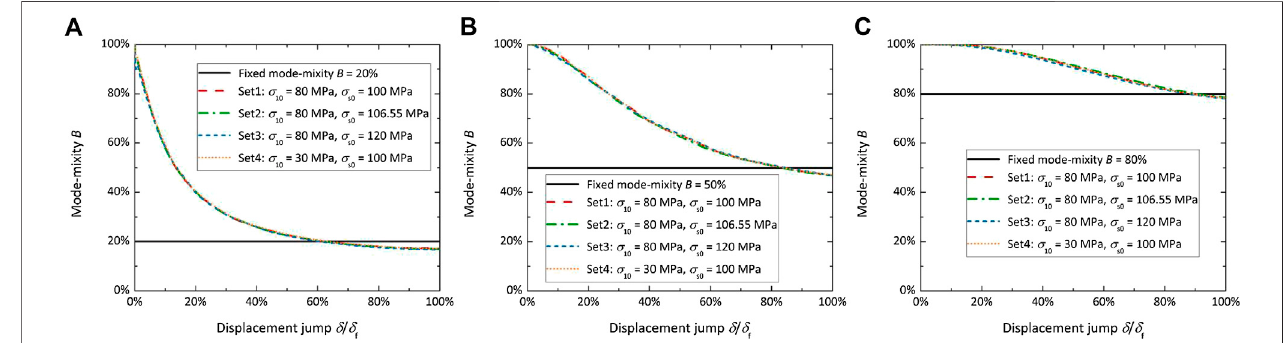
FIGURE6| Changeofthemodemixityattheintegrationpointwhichis5 mmawayfromthepre-cracktipwith: (A) modemixityof20%; (B) modemixityof50%; (C) mode mixity of 80%.